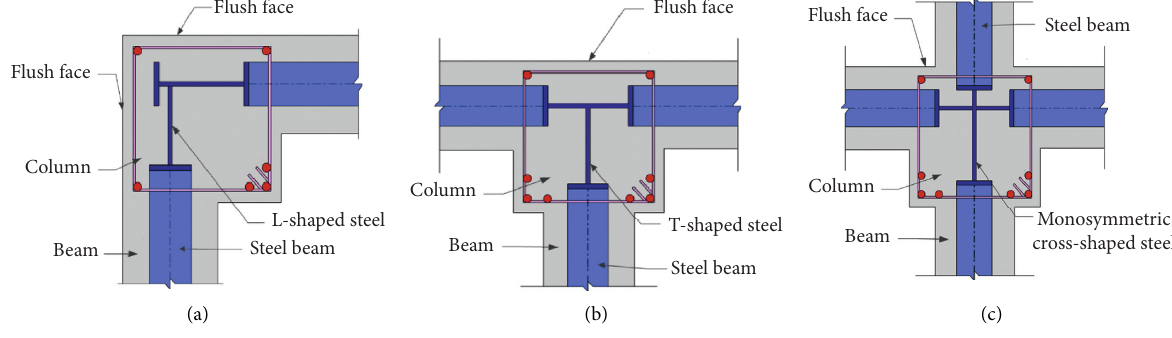
Figure 1: Three types of beam-column joints: (a) corner, (b) border, and (c)